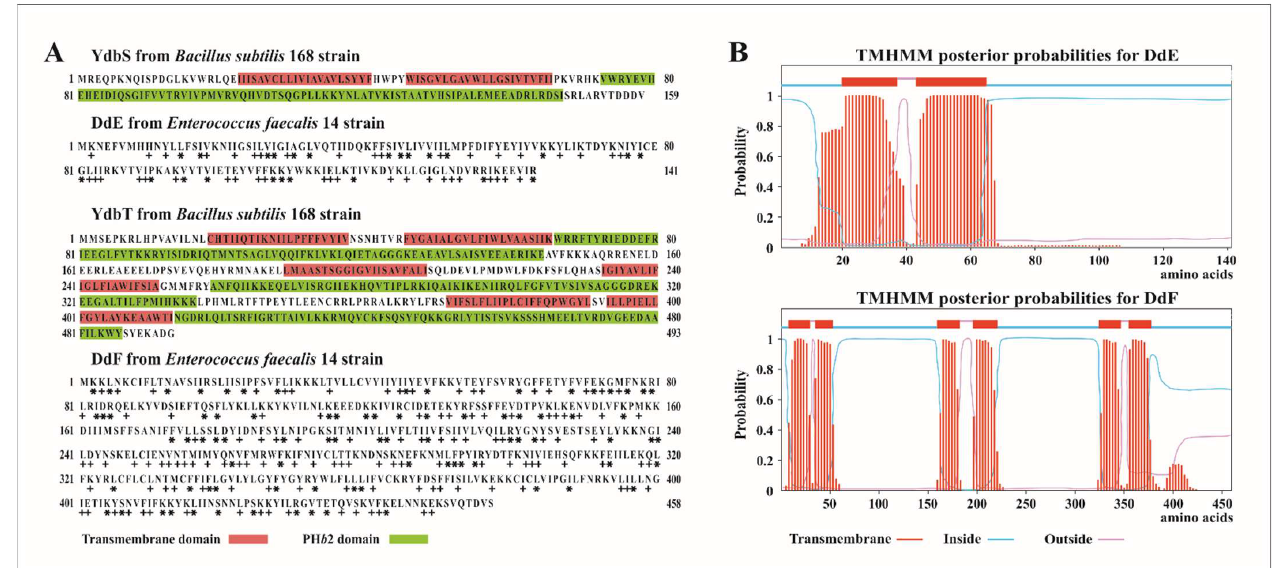
Figure 1. ( A ) Amino acid sequences of the YdbS and YdbT proteins, where their transmembrane and PH b 2 domains are highlighted (data taken from PDB). In addition, amino acids sequences of DdE and DdF proteins are depicted showing their identical (*) and positive (+) amino acid residues when aligned with YdbS and YdbT, respectively. ( B ) Transmembrane domains predicted for the DdE and DdF proteins.